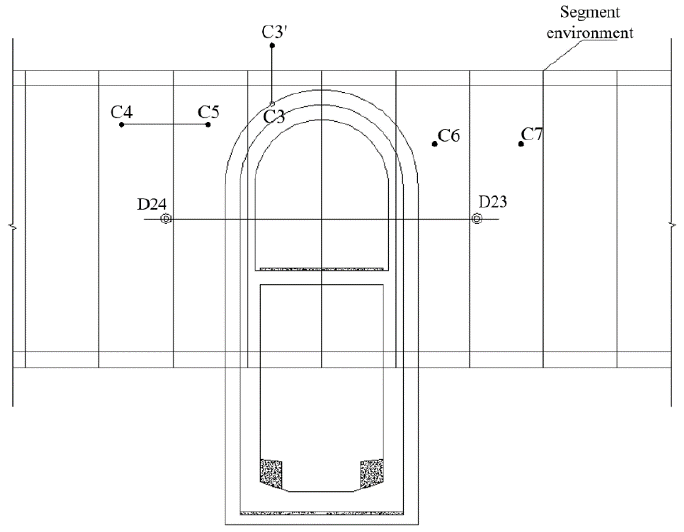
Figure 3. Contralateral freezing hole layout.